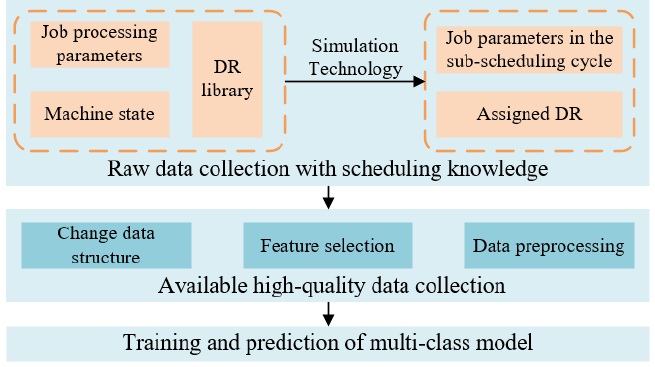
Figure 5. Decision model construction process.